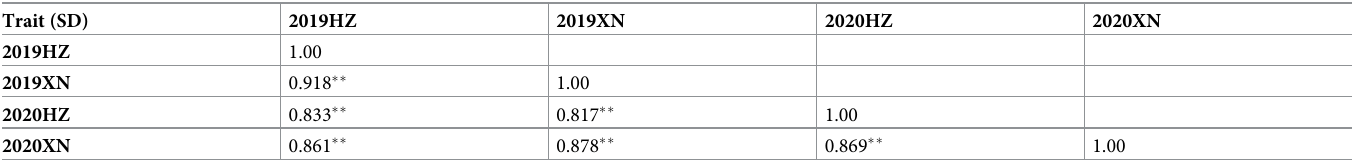
2019HZ, 2019XN, 2020HZ, and2020XN represent seed density per silique in four different environments (Huzhu and Xining) in 2019 and 2020, respectively; �� represents significance at the P = 0.01 level.